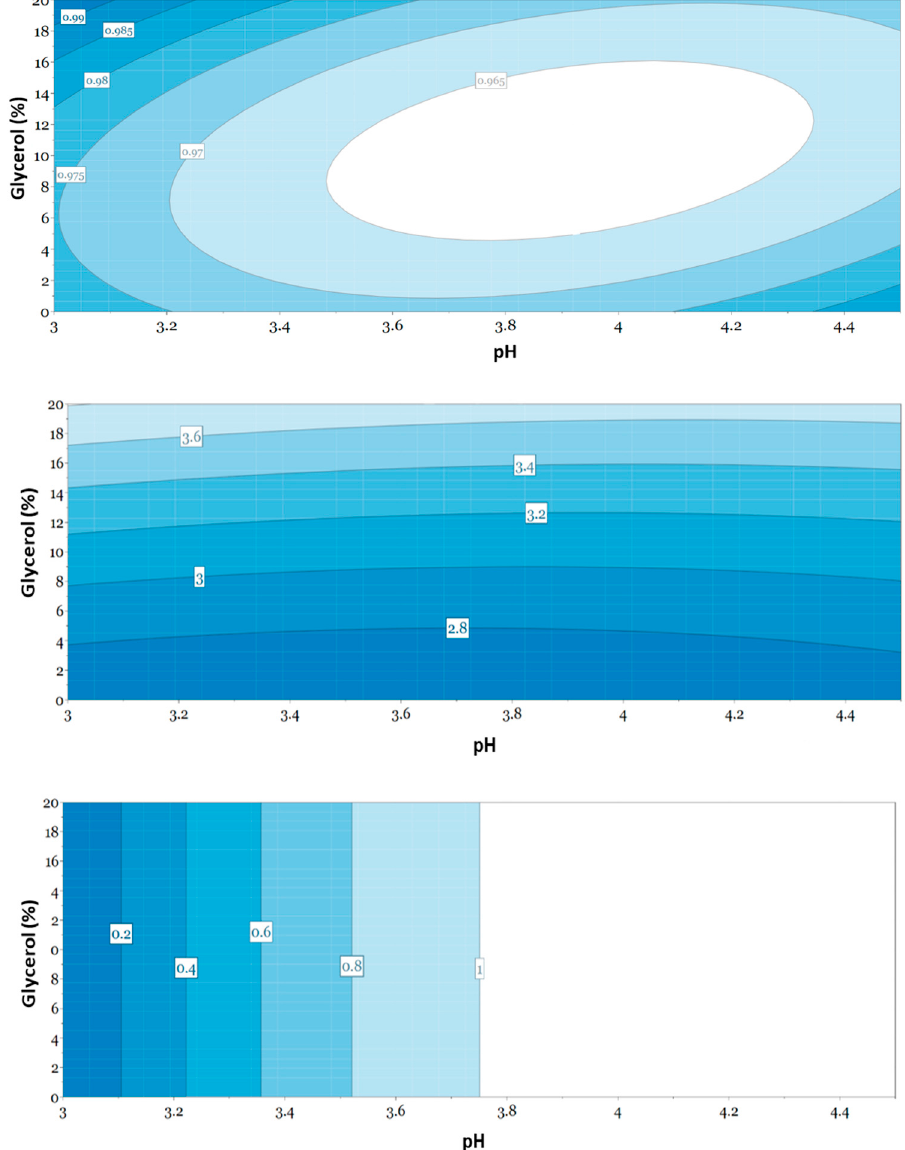
Figure 4. Response contour plot for responses dispensed dose (dosing accuracy) ( top figure ), vis- cosity ( middle figure ) and solubility ( bottom figure ) as a function of amount of glycerol and pH. Compositions of formulations N1–N12 according to Table 4, containing naloxone. The target dose was 1 mL, corresponding to 1 mg naloxone. ±10% of the intended dose was considered an acceptable dosing accuracy. Values above 1 in the solubility plot indicate that naloxone is soluble in the formulation, values below 1 indicate that naloxone is not soluble.